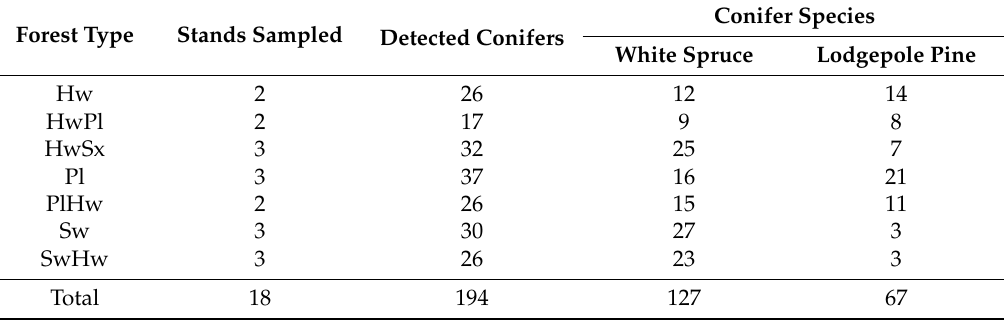
PlHw SwHw Total 18 194